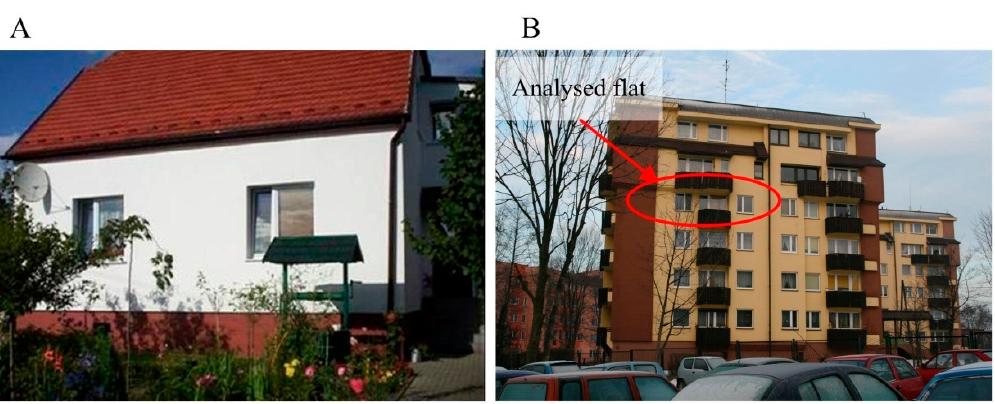
Figure 2. View of measured buildings; ( A )—apartment I (ground floor); ( B )—apartment II (third floor).